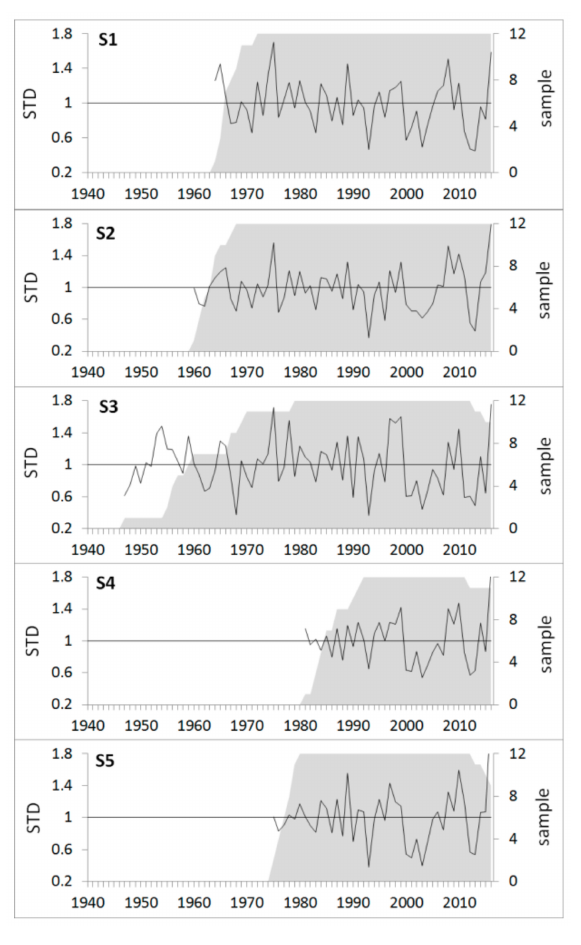
Figure 6. Standard chronologies (STD) of the sites, with sample replication in grey (S1–S5 denote the five study